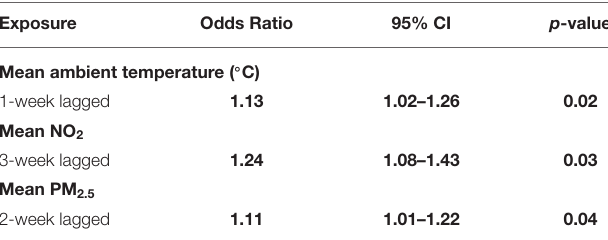
TABLE 3 | Univariable associations between weekly average ambient exposures and increased proportions of lower airway granulocytes ( n = 78, 2007–2017). Exposure